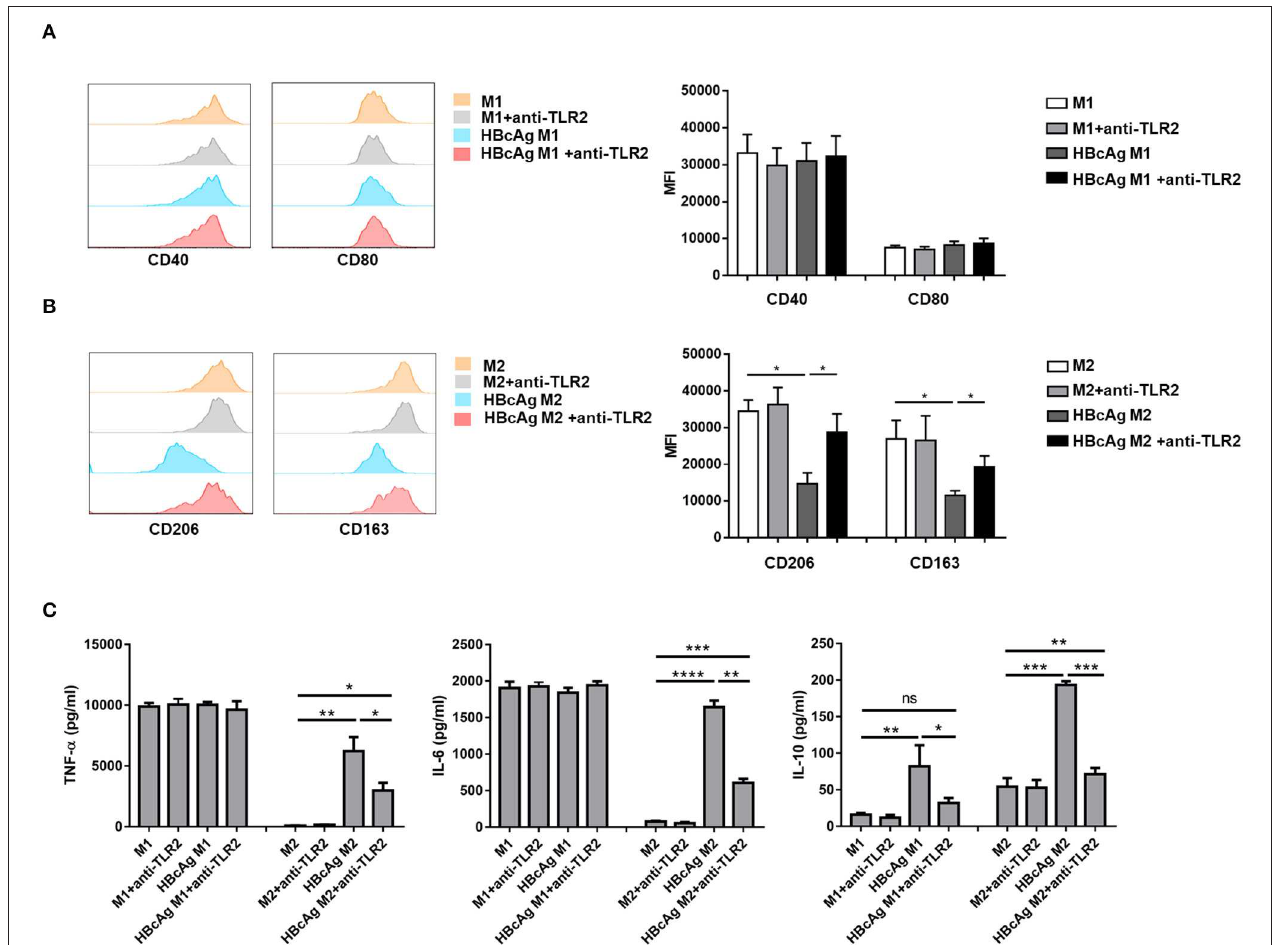
FIGURE 5 | TLR2 blockade abolished the impaired M2 polarization induced by HBcAg. (A–C) For TLR2 blocking assay, unpolarized M1 and M2 M Φ were pretreated with 0.10 µ g/ml anti-TLR2 for 4h before incubated with LPS/IFN- γ , IL-4, HBcAg, or PBS. (A) Representative flow cytometric graphs (left) and cumulative MFI (right) showing CD40 and CD80 expression levels in M1 M Φ . (B) Representative flow cytometric graphs (left) and cumulative MFI (right) showing CD206 and CD163 expression levels in M2 M Φ . (C) Supernatants of M1 and M2 M Φ stimulated with HBcAg, PBS, and anti-TLR2 were collected to measure TNF- α , IL-6, and IL-10 productions by ELISA. Experiments in (A,B) were repeated at least two times. Data were analyzed using a paired Student’s t -test. Results are shown as the mean ± SEM ( A–C , n = 5). * p < 0.05, ** p < 0.01, *** p < 0.001, **** p <